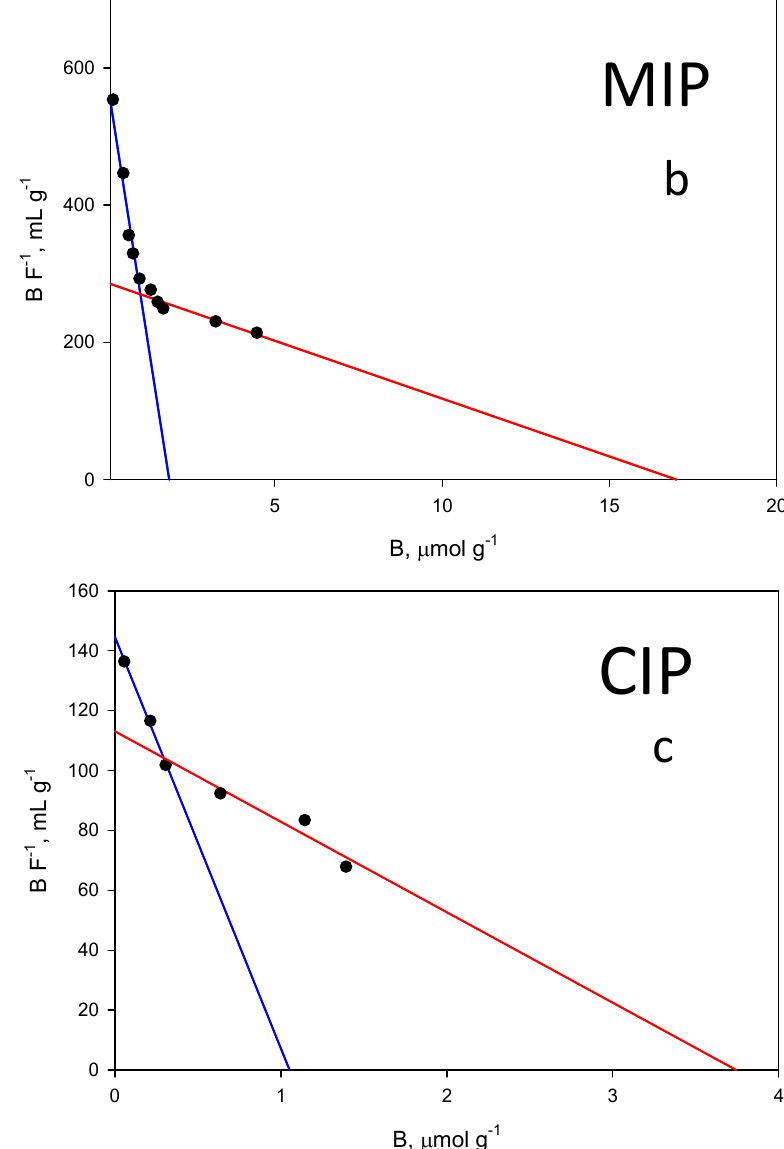
Figure 6. ( a ) Equilibrium binding isotherms for ZON to the MIP (blue) and to the corresponding CIP (red) in phosphate buffer (50 mM, pH 7.5). ( b ) Scatchard fitting for the MIP and ( c ) the CIP. High affinity, blue lines. Low affinity, red lines.